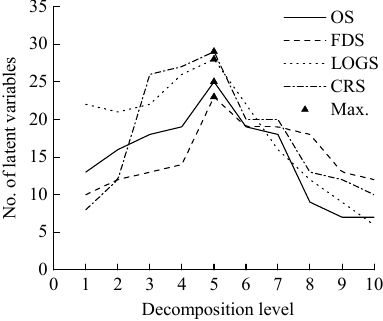
Figure 6. The number of latent variables in a partial least squares regression based on approximation coefficients.